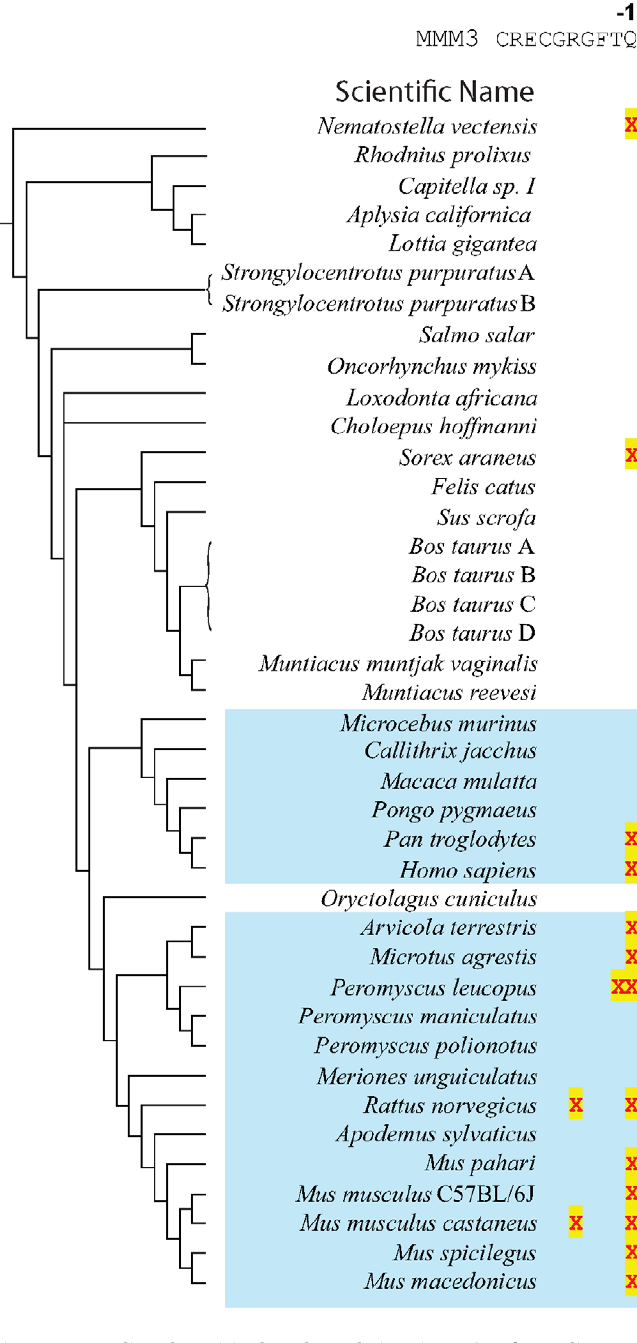
Figure 6. Predicted positively selected sites in Prdm9 from divergent metazoan lineages. Results for previously presented rodent and primate lineages are also shown here for comparison (blue shading). Positive selection was inferred for each species [27] from intra-species Prdm9 zinc finger sequence alignments. Positively selected sites ( P , 0.05 after multiple testing correction) are shown mapped to the third mouse Prdm9 zinc finger sequence (MMM3). The majority of positively selected sites, across 700 million years of divergence from sea anemone to mammals, fall at positions 2 1, 3, and 6. The inferences of positive selection for Capitella were made on the basis of three sequences on separate unassembled genomic scaffolds. Despite their high sequence similarity, multiple uncorrelated point substitutions, especially among the zinc fingers, suggest that they may represent allelic copies or rapidly diverging paralogues.